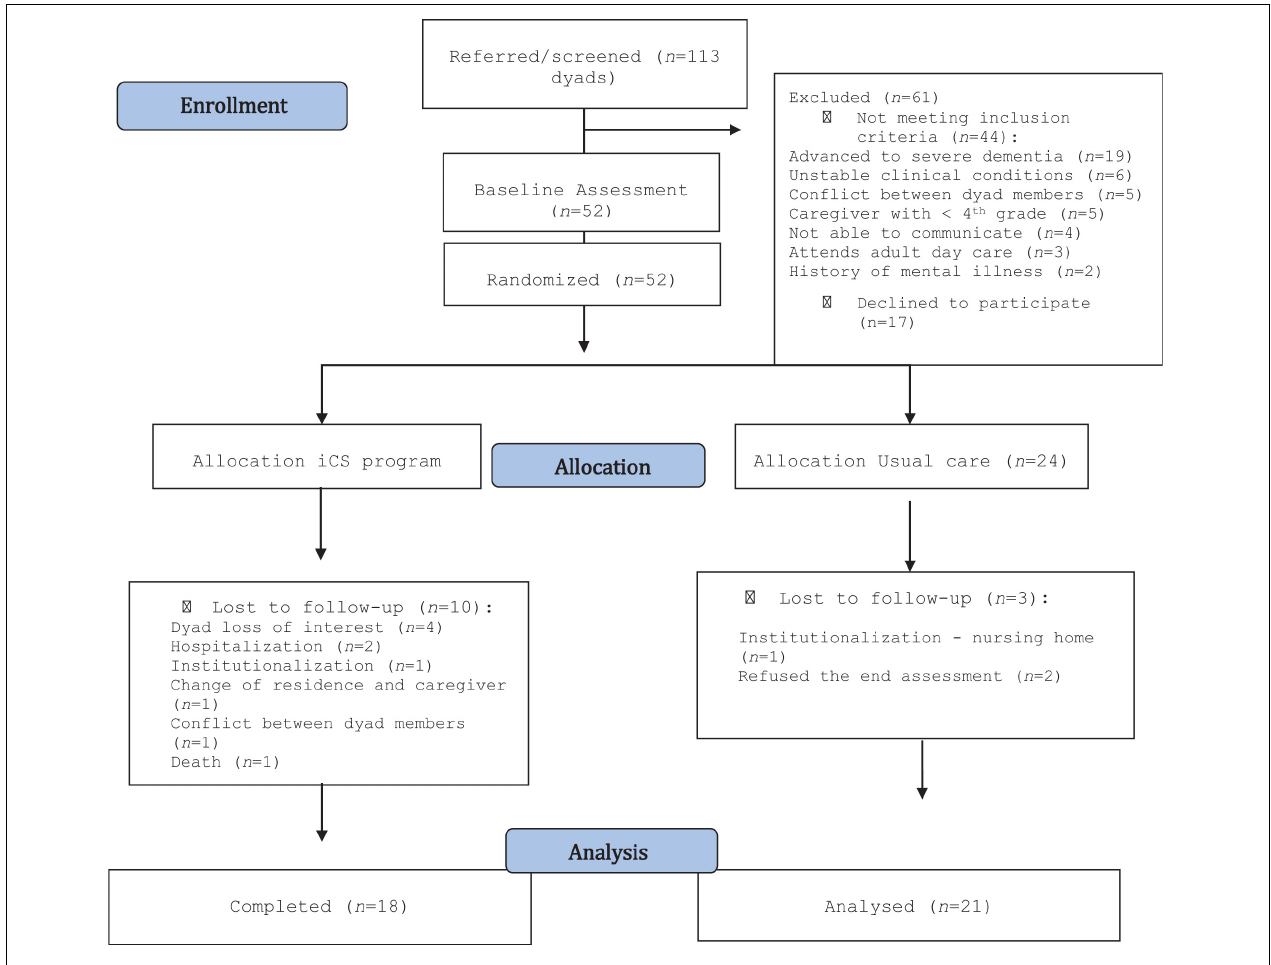
FIGURE 1 | Participant flow through the trial (Moher et al.,